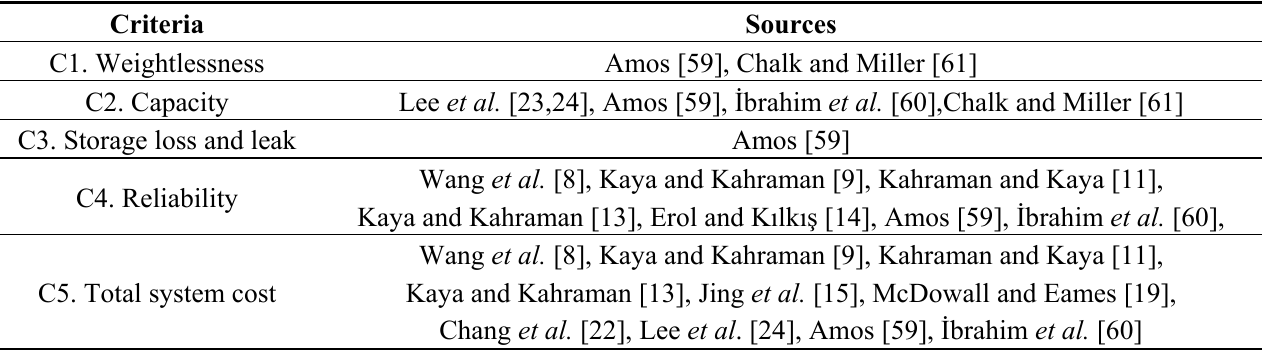
Table 2. Summary of literature review to evaluation criteria.